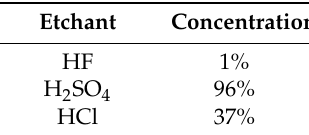
Table 1. The concentration of the acid used in the study.